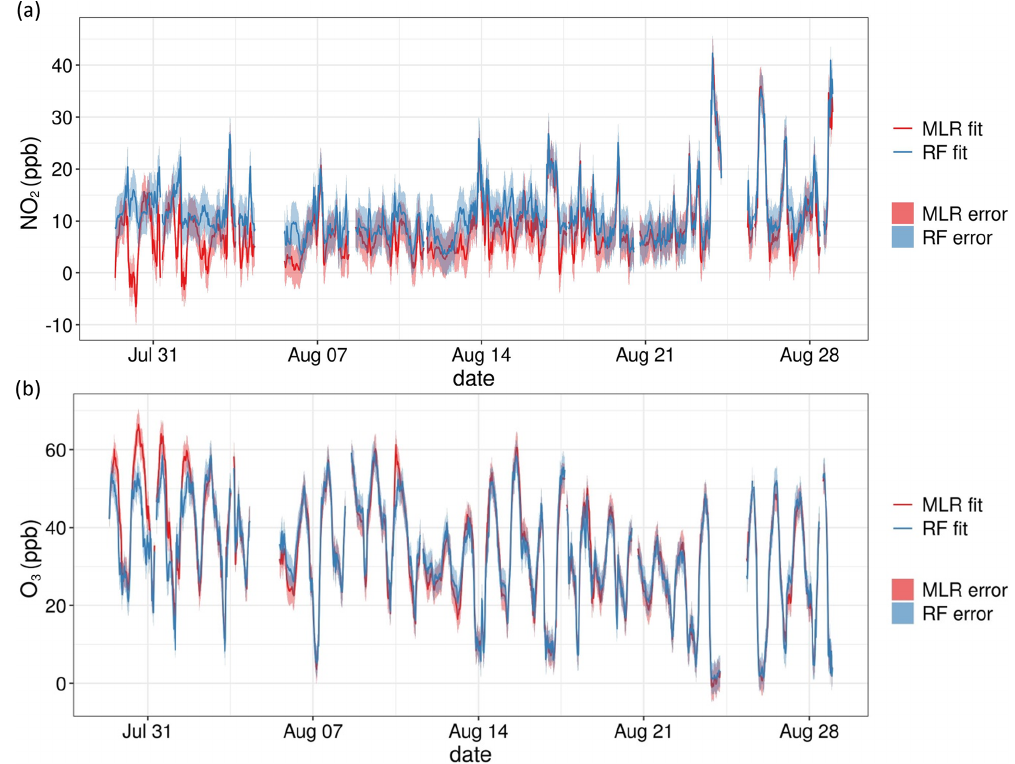
Figure 13. Time series plots of both MLR and RF predictions for Experiment 1 including the measurement uncertainty as shaded regions for (a) NO 2 and (b) O 3 . Data were averaged to 30min